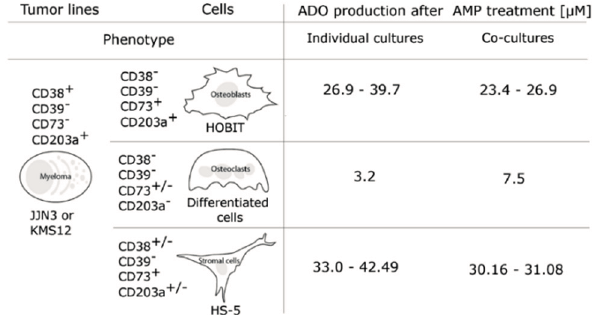
Figure 4. Production of ADO in co-cultures of a myeloma cell line, osteoblasts, osteoclasts (PBMC isolated from BM samples of MM (multiple myeloma) patients) and stromal cell line after